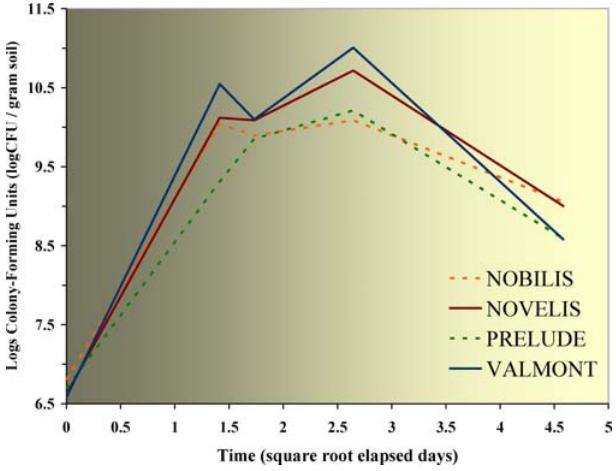
CFU growing curves in amended soils. Dotted lines for crop residues from conventional maize, continuous lines for transgenic maize. Trans- genic maize straws show a much higher number of CFUs than conventional straws during the first week (ANOVA: p ¼ 0.0296), but the differences between all four maize cultivars are not significant (ANOVA: p ¼ 0.1389).